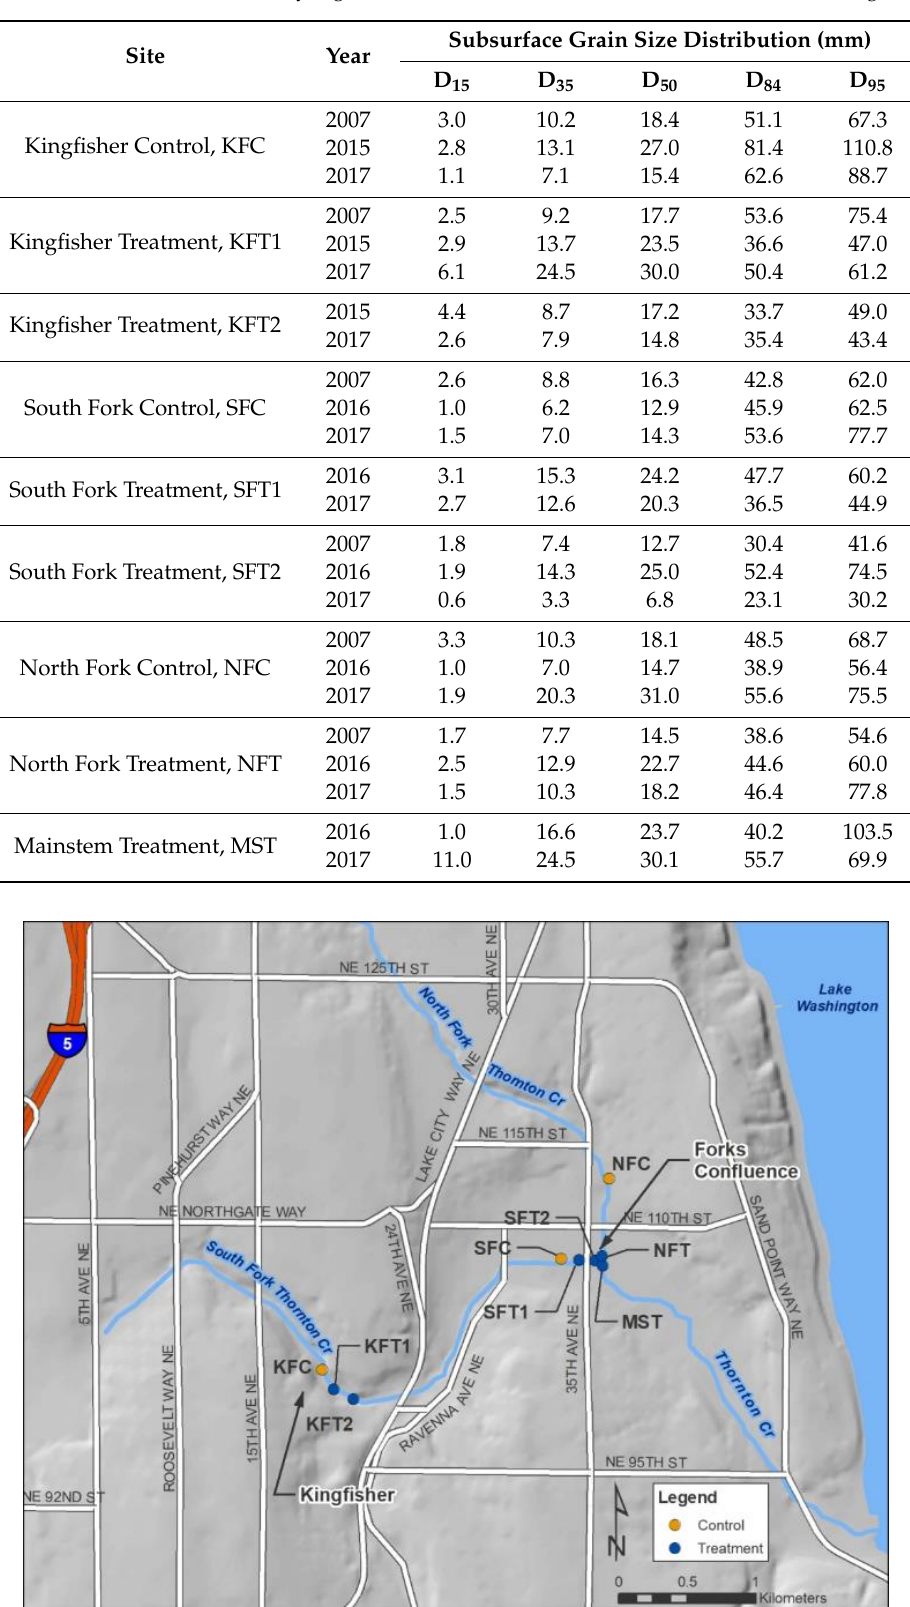
Figure A1. Locations of streambed sediment sampling sites referenced in Tables A1 and